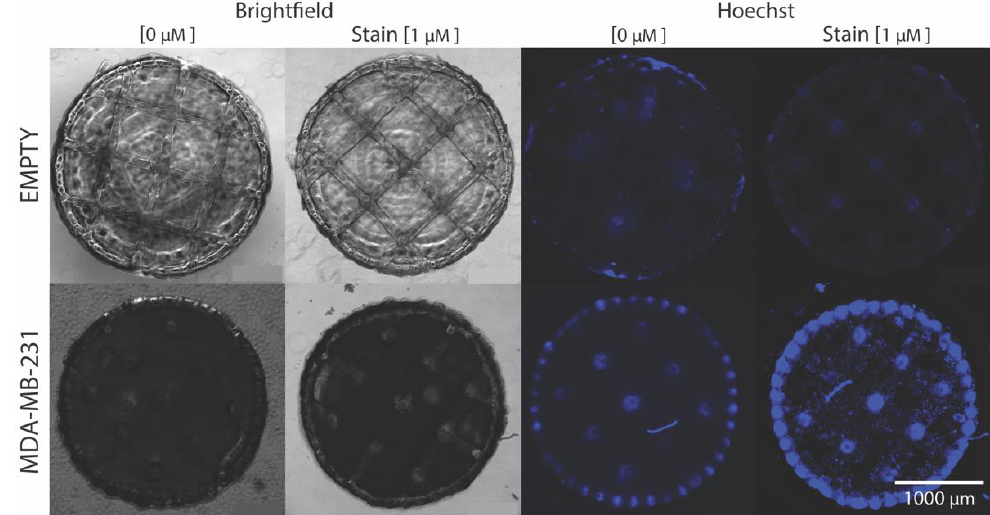
Figure 7. Live MDA-MB-231 seeded basket imaged with a Zeiss AXIO Observer 5X objective. Cellular fluorescence signal (blue) from Hoechst stain highlights cellular integration to the basket structure.